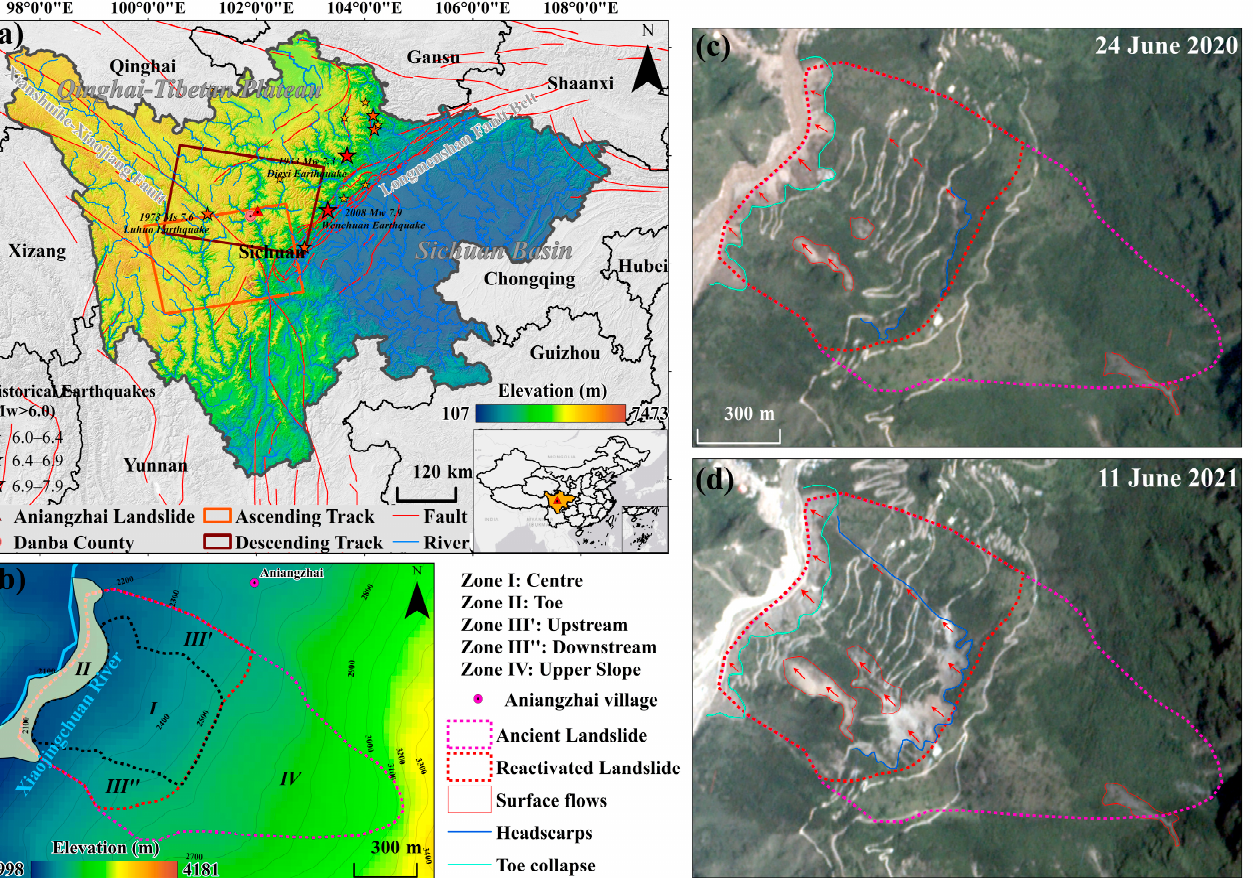
Figure 1. Geological background of the study area. ( a ) Regional elevation map; ( b ) Enlarged view of the ANZ landslide; ( c , d ) Post-failure true colour optical images collected from the PlanetScope satellite (Table 1 shows technical specifications of the PlanetScope optical